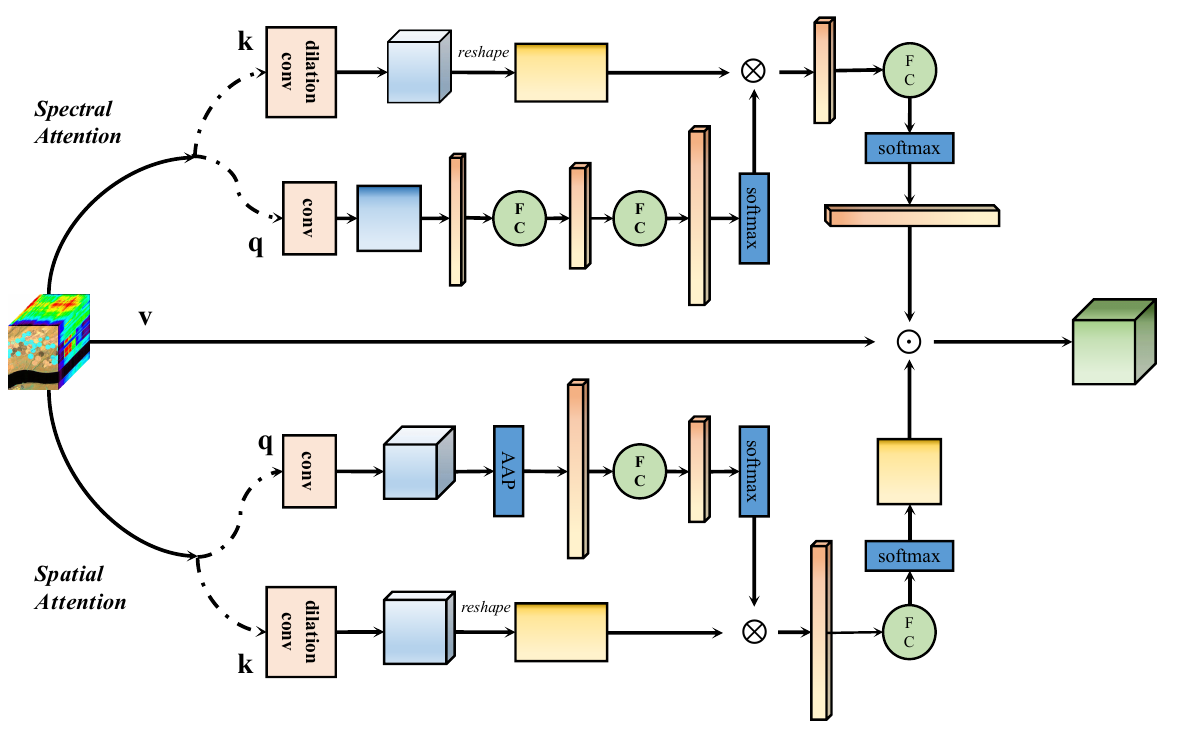
Figure 2. The detailed design of the proposed PS 2 A module. The top part denotes the generation procedure of the spectral attention map, and the bottom part denotes the generation procedure of the spatial attention